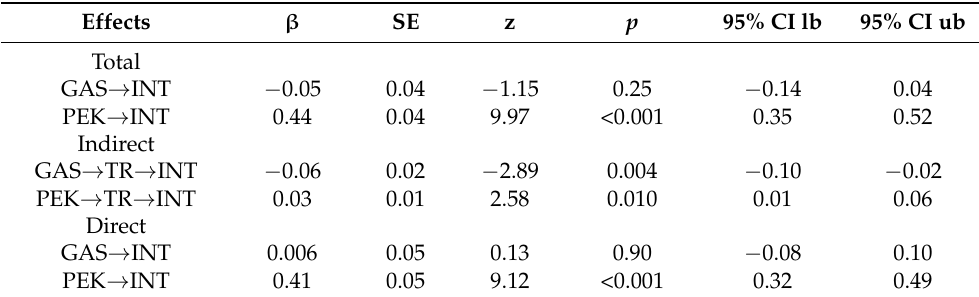
Table 5. Results of the mediation model.